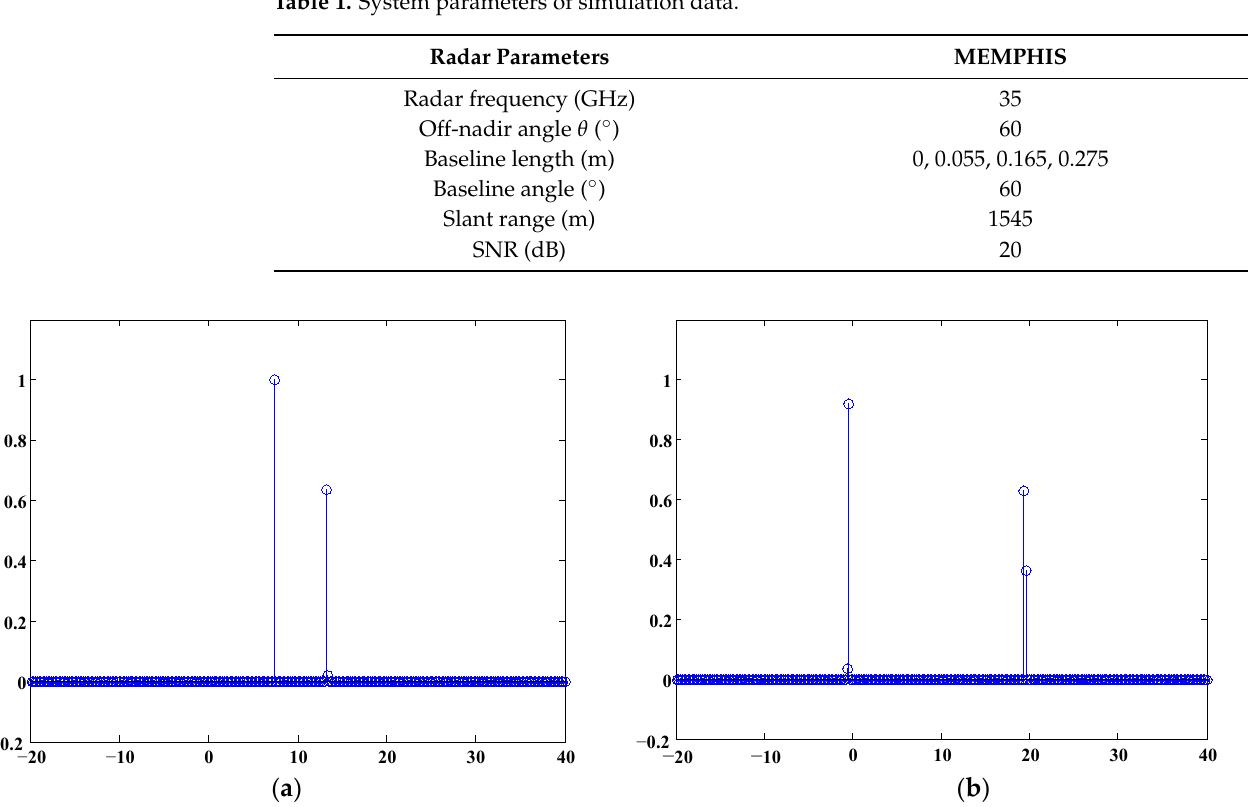
Figure 2. Simulation results provided by two methods. ( a ) Traditional L1 norm compressive sensing method; ( b ) Multi-look compressive sensing method. The horizontal axes are heights in the elevation direction with the unit m, and the vertical axes are normalized amplitudes.